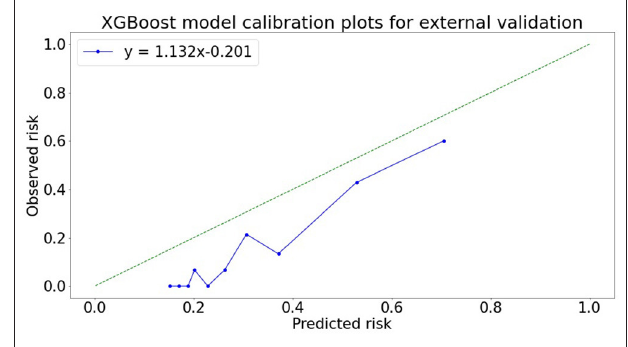
FIGURE 2 | XG boost model calibration plot in external